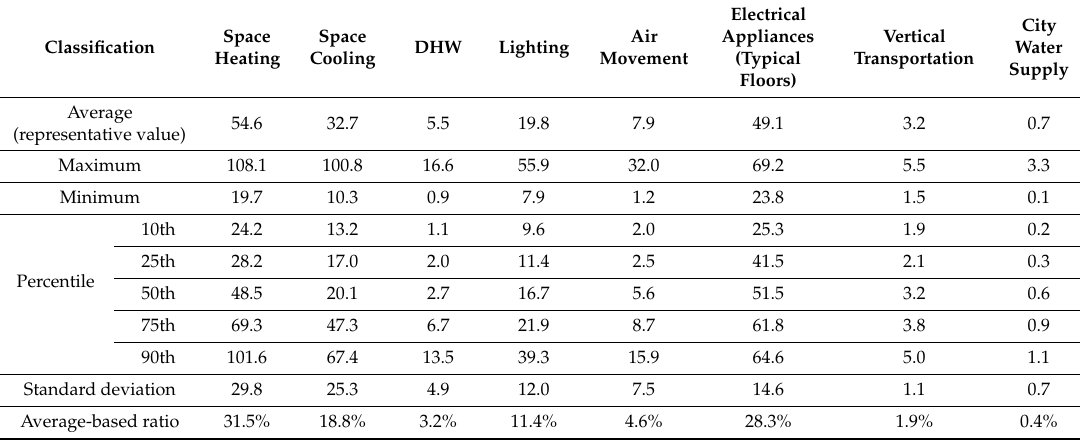
Table 12. Statistics of site EUIs (kWh / m 2 ·